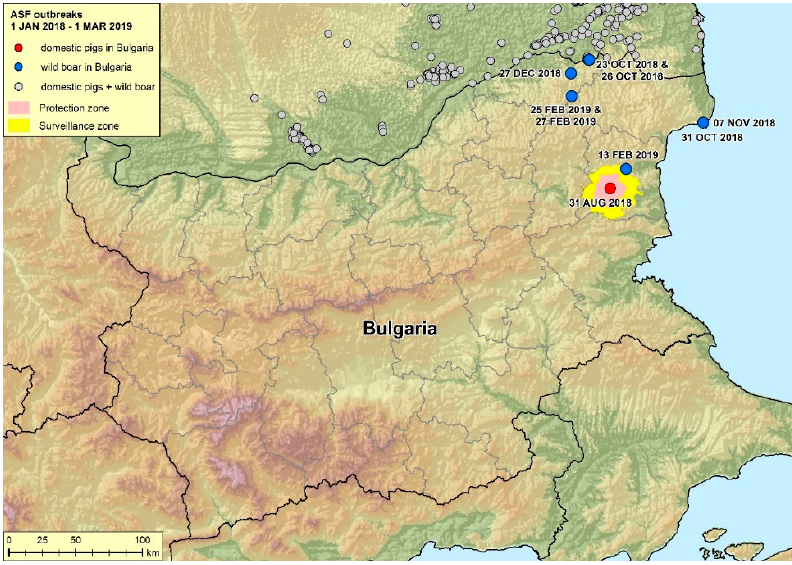
Figure 1. Map of reported ASF outbreaks in Bulgaria and bordering areas (1 January 2018–1 March 2019). The red dot marks the location of the described Bulgarian backyard farm. Blue dots indicate Bulgarian wild boar cases. ASF cases in bordering countries are colored in grey. Protection and surveillance zones are mapped according the COMMISSION IMPLEMENTING DECISION (EU) 2018/1280. P. Wysocki, Friedrich-Loeffler-Institut, Source: ADNS.